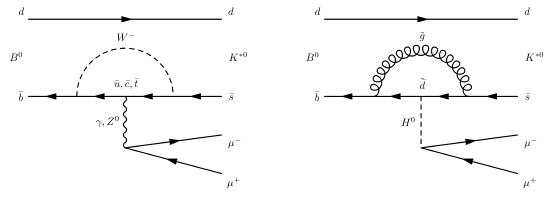
Figure 1. Examples of Feynman diagrams of the B 0 → K ∗ 0 µ + µ − decay within the SM (left), and within the MSSM